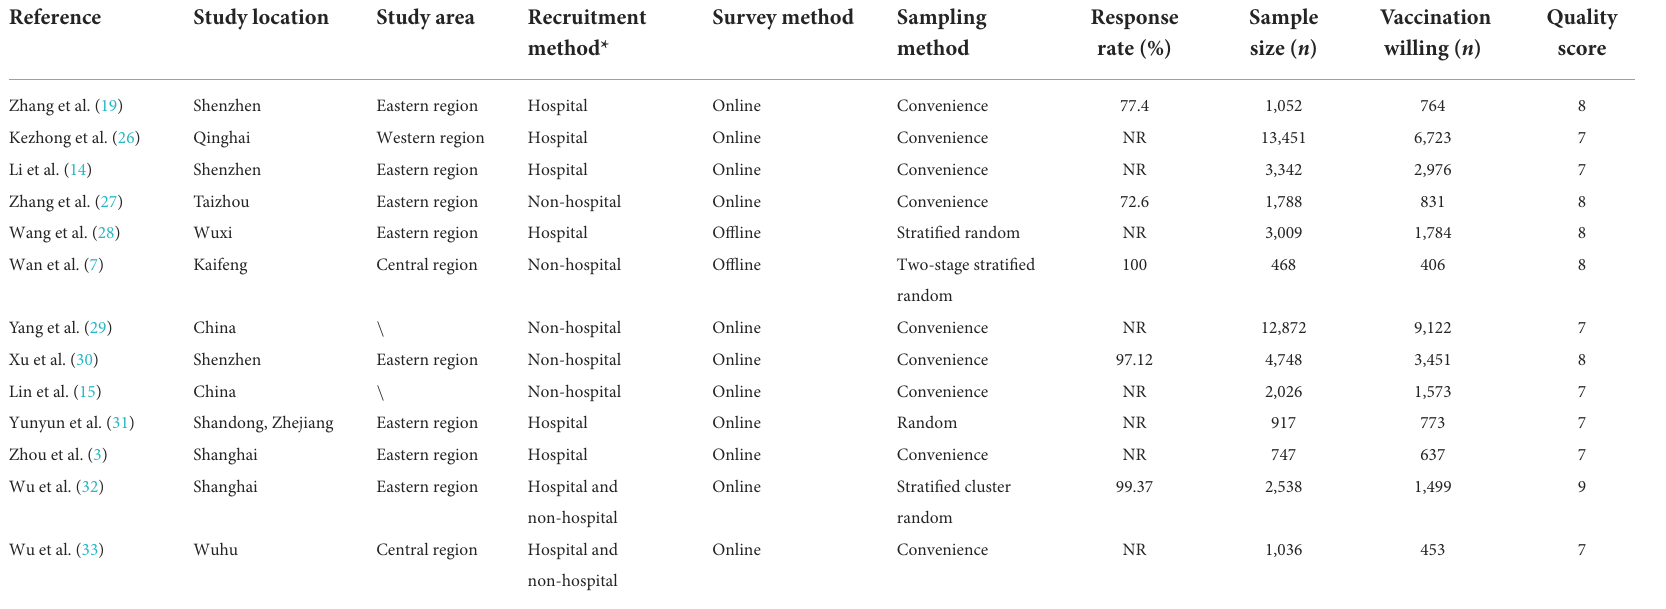
TABLE 1 Characteristics of included